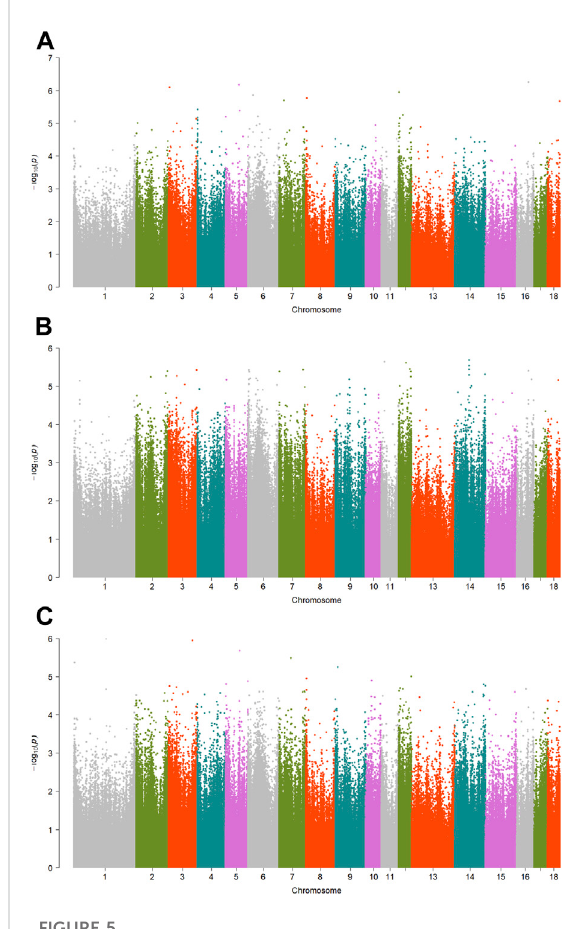
FIGURE 5 Manhattan plots showing EWAS results for other traits. Each dot represents an CpG site. (A) Manhattan plot showing EWAS results for pH 45min . (B) Manhattan plot showing EWAS results for pH 24h . (C) Manhattan plot showing EWAS results for